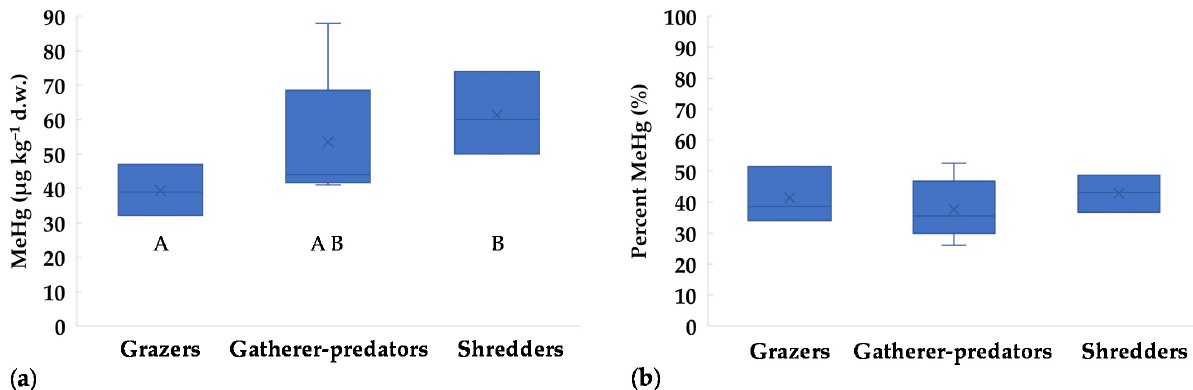
Figure 3. Concentrations of methylmercury in different Functional Feeding Groups (FFGs) collected in the Toce River downstream of the industrial site in 2017: ( a ) MeHg as µg kg − 1 d.w.; ( b ) MeHg as percent relative to THg. x = mean value, horizontal line in boxes = median value, box = 25th–75th percentiles, whiskers = min-max range. Uppercase letters represent significant differences between FFGs according to Kruskall-Walis ANOVA test followed by Dunn’s post-hoc ( p < 0.05).